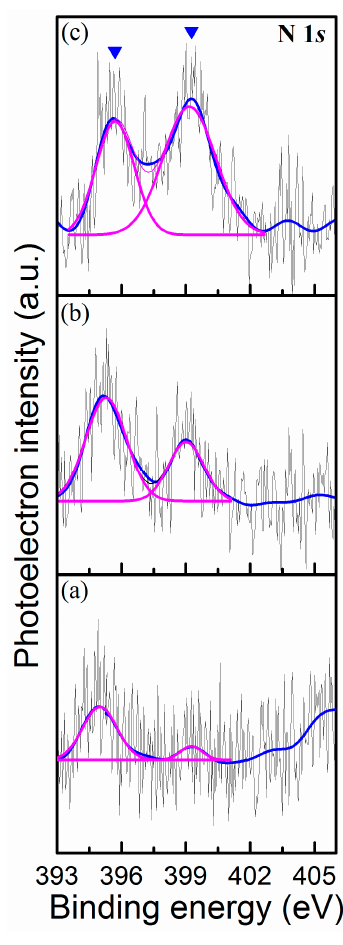
Figure 3. N 1s XPS spectra for the samples (a) A, (b) B, and (c) C, respectively.